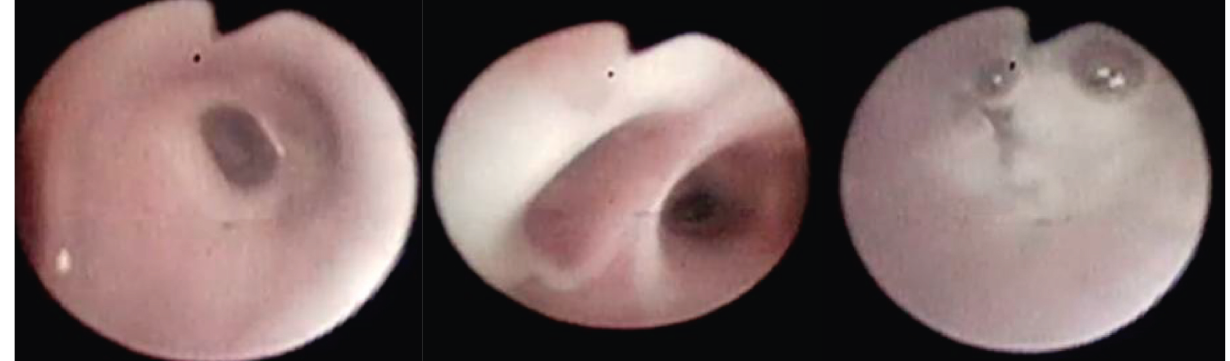
Figure 2: Thick purulent secretions on flexible